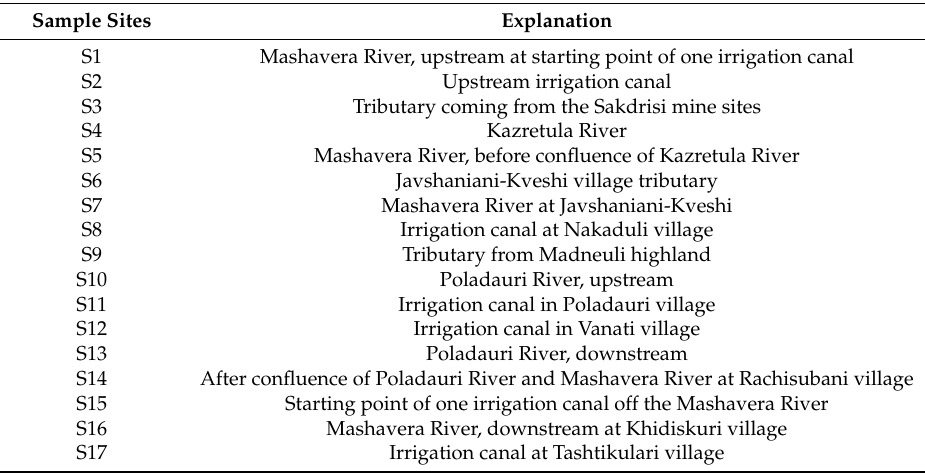
Table 1. Description of the sampling